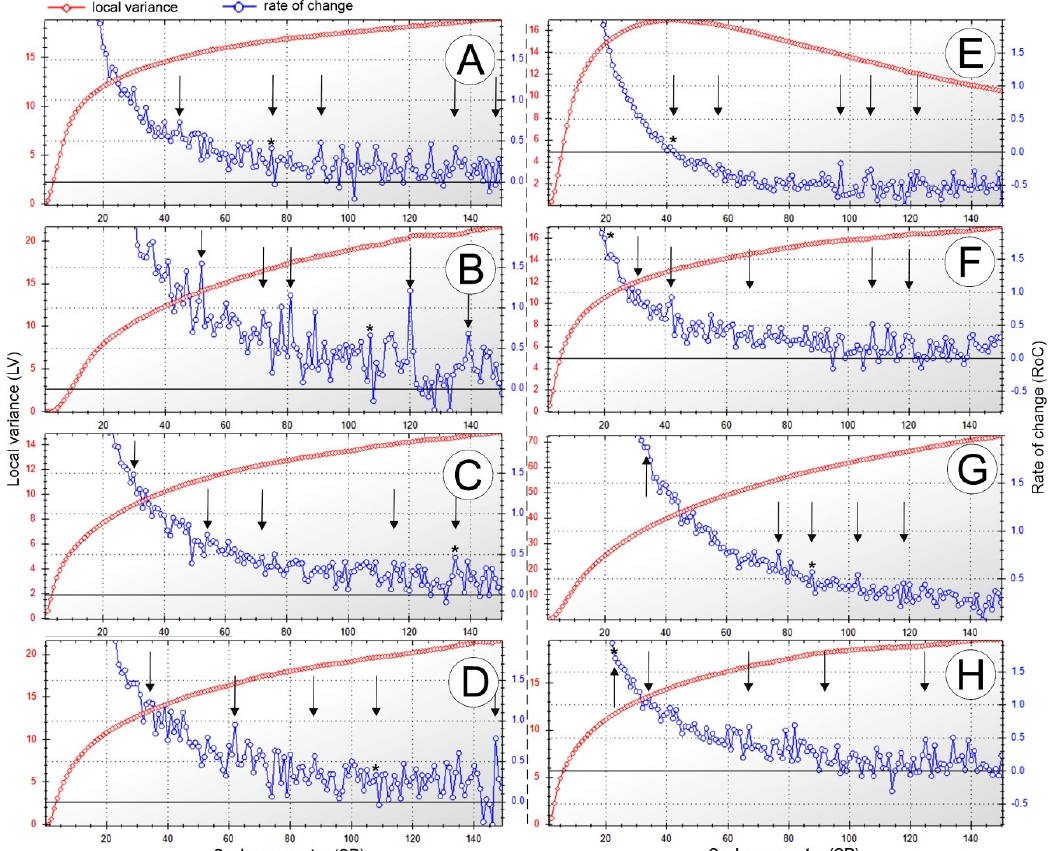
Figure 4. The enhanced estimation scale parameter (ESP2) plug-in ROC local variance (LV) graph output: ( A ) 1957, ( B ) 1965, ( C ) 1973, ( D ) 1997, ( E ) 2006, ( F ) 2010, ( G ) 2015, and ( H ) 2018; the SP values proposed by ESP2 at level 1 are marked with an asterisk.